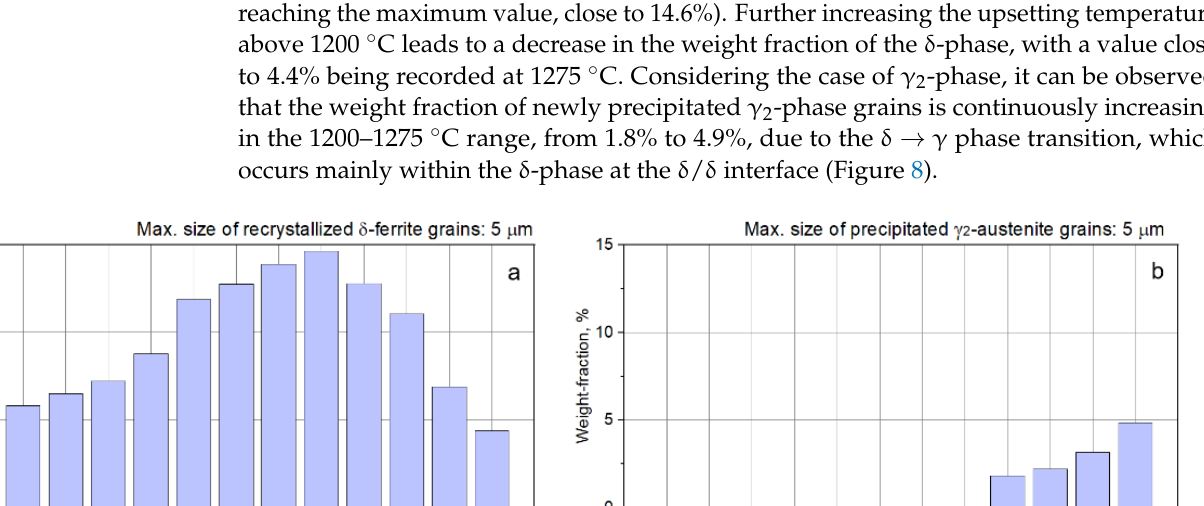
Figure 9. Weight fraction of recrystallized δ -phase ( a ) and precipitated γ 2 -phase ( b ) grains as a function of deformation temperature.